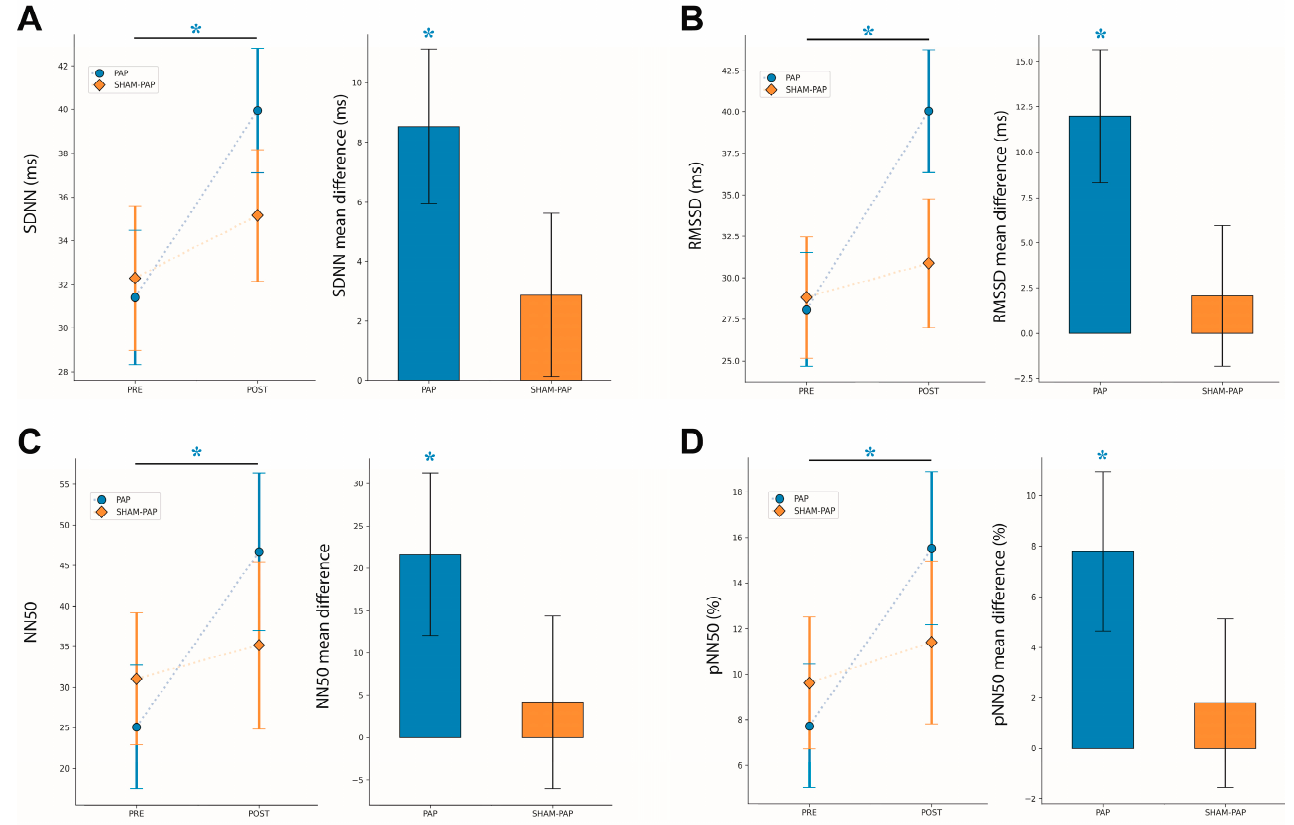
Figure 3. Time-domain parameters of HRV at rest, pre- and post-treatment. ( A ) SDNN, ( B ) RMSSD, ( C ) NN50, ( D ) pNN50. Data presented are mean ± standard errors of the mean (SEM). Asterisk marks a significant difference ( p < 0.05).